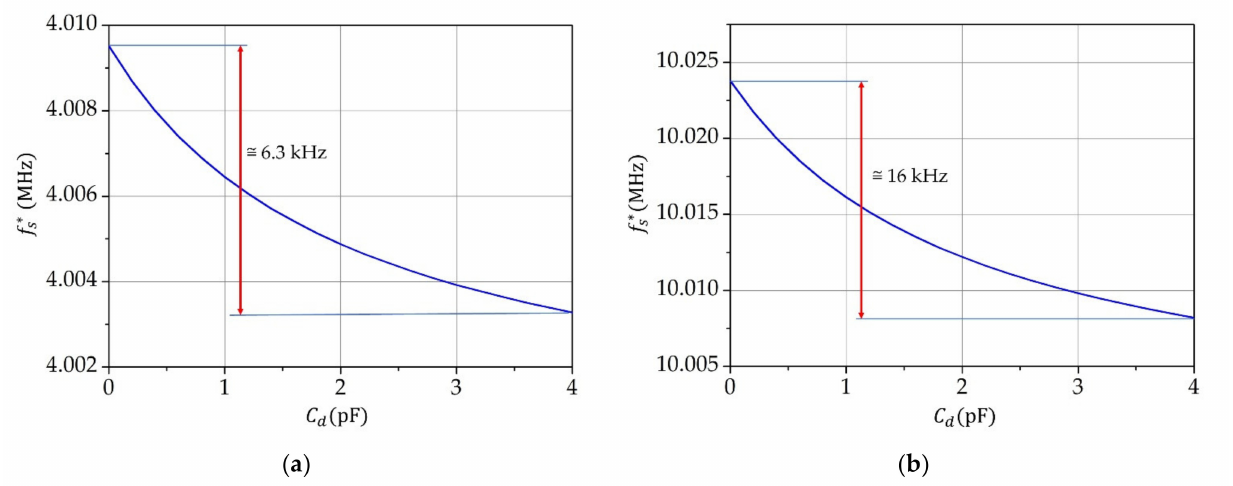
Figure 2. Resonant frequency f s ∗ as a function of capacitance C d for: ( a ) 4 MHz and ( b ) 10 MHz crystal. A change of capacitance C d triggers a change of the oscillator’s frequency f osc 1 in the range between 1 and 20 kHz. Modulation of two frequencies ( f osc 1 and f ref ) leads to the formation of a triangular signal on a low-pass filter, with resistance R and capacitance C , which is then changed by the Shmitt circuit (to reduce interference when the frequency, f out , is measured) into a square signal [32,36–38,42], with frequency f out :